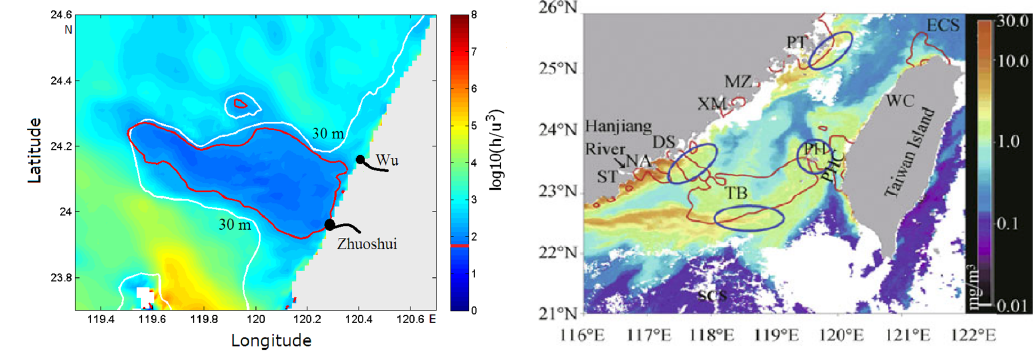
Figure 7. Left panel: planar plot of computed SH parameter in the coastal zone over the CYR area including Zhuoshiu and Wu rivers’ mouths. The contour of K SHc = 1.78 (red line) and isobath of 30m delineating the CYR (white line) are shown. The modelled K SH corresponds to flood phase at 11:00GMT, 27 June 2013. Right panel: MODIS images of Chl a on 9 July 2009. The contours for the critical tidal mixing parameter ( K SHc = 1.78) estimated from CTD measurements by Zhu et al. (2013) are shown in red. Locations of the summertime upwelling cores in the TS are shown with blue ellipses. Acronyms are given in Fig.